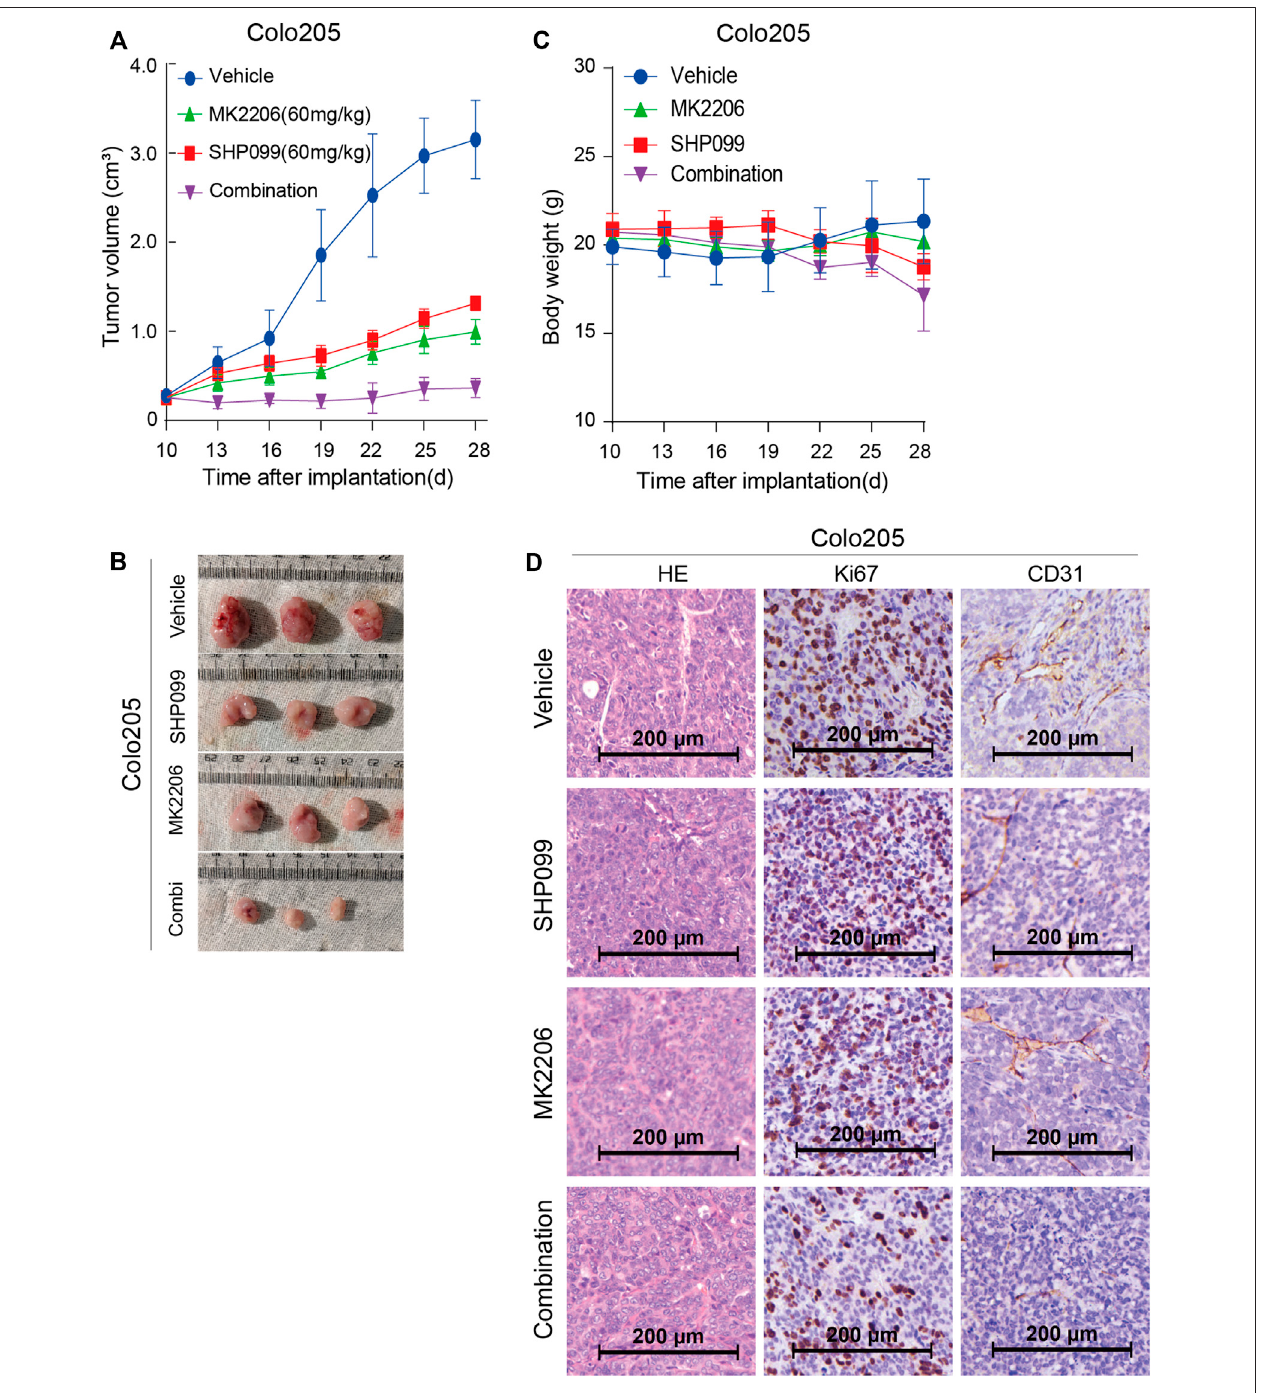
FIGURE4| EffectofSHP099andMK-2206onthegrowthofxenograftCRCtumors. (A) DynamiceffectofSHP099 andMK-2206ontheCRCtumor volumes. (B) Represented images from isolated CRC tumors receiving SHP099 and MK-2206 treatment. (C) The body weight of animals during the treatment of SHP099 and MK- 2206. (D) The effect of SHP099 and MK-2206 on the expression pattern of Ki67, and CD31 in isolated xenograft tumors examined by IHC.